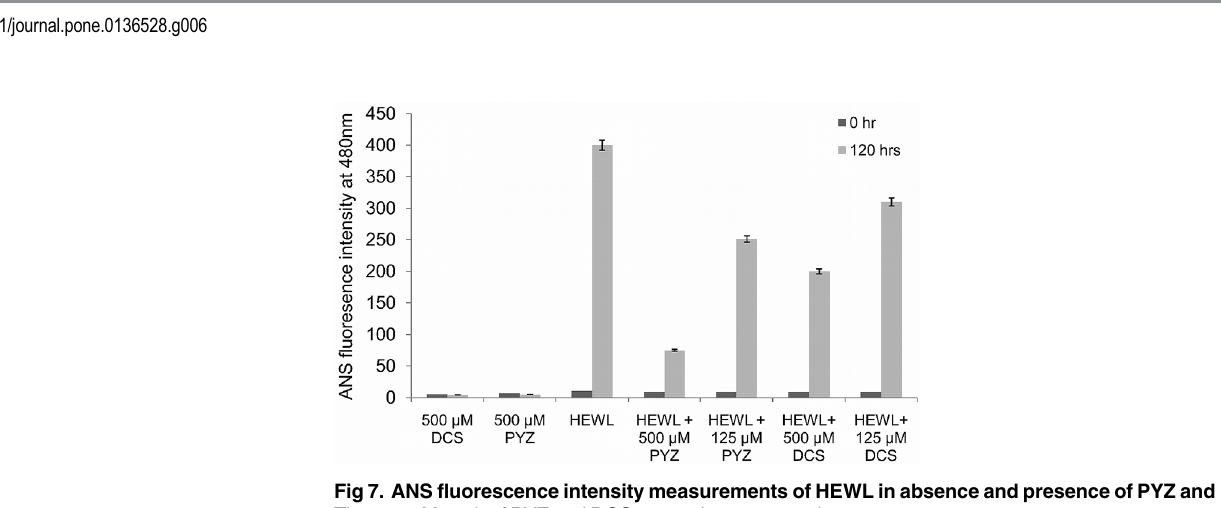
PLOS ONE | DOI:10.1371/journal.pone.0136528 August 27,